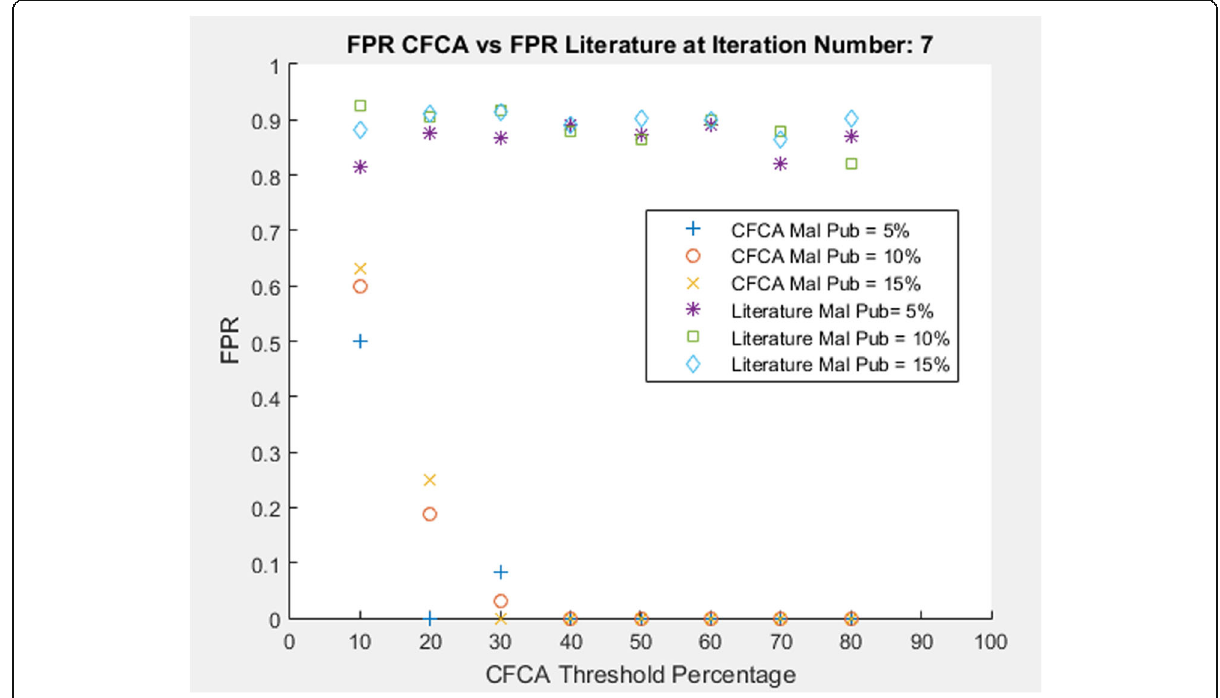
Fig. 9 FPR CFCA vs FPR literature at iteration 7